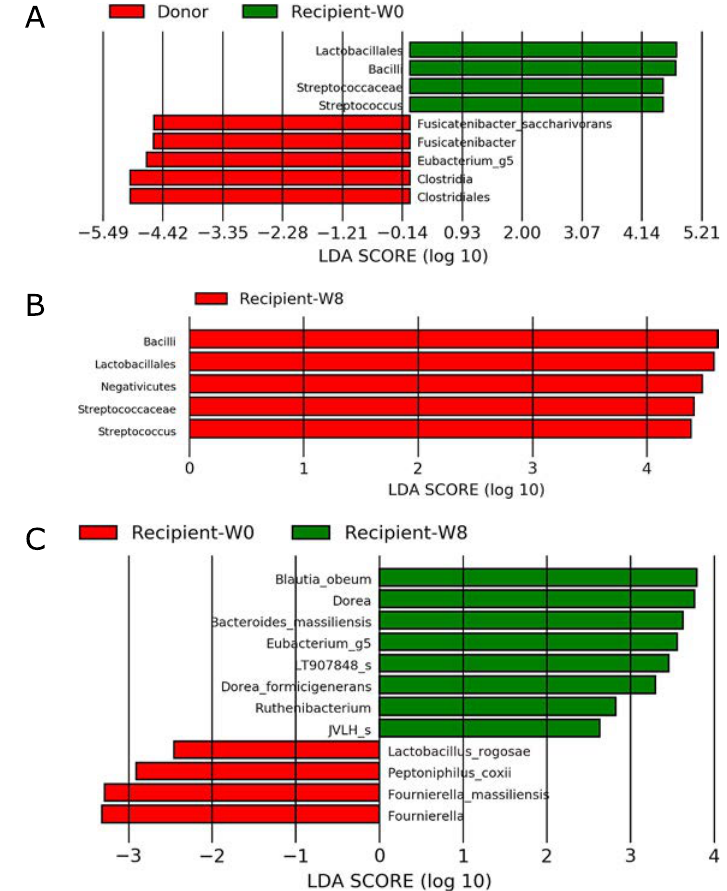
Figure 3 Linear discriminant analysis effect size. The analysis was performed using LEfSe version 1.0.7. A. Responders with ulcerative colitis before fecal microbiota transplantation compared with donors (n=5). B. Responders with ulcerative colitis at 8 weeks after fecal microbiota transplantation compared with donors (n=5). C. Comparison of ulcerative colitis responders between before and 8 weeks after fecal microbiota